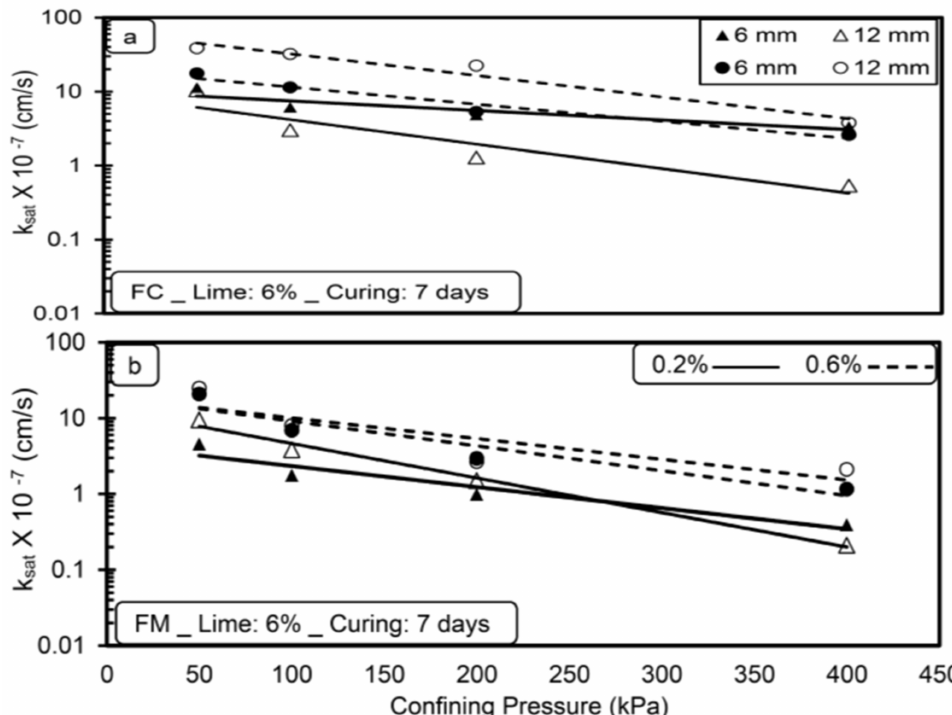
Figure 5. Variations in saturated hydraulic conductivity (k sat ) with confining pressure ( a ) FC ( b ) FM with lime treatment (after 7-day curing period).